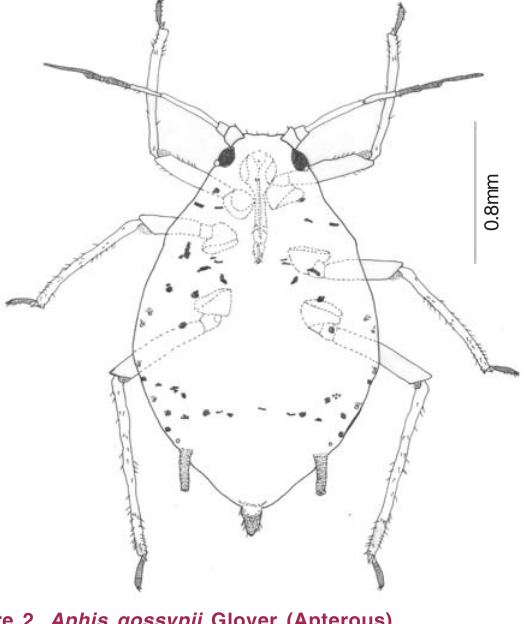
Figure 2. Aphis gossypii Glover